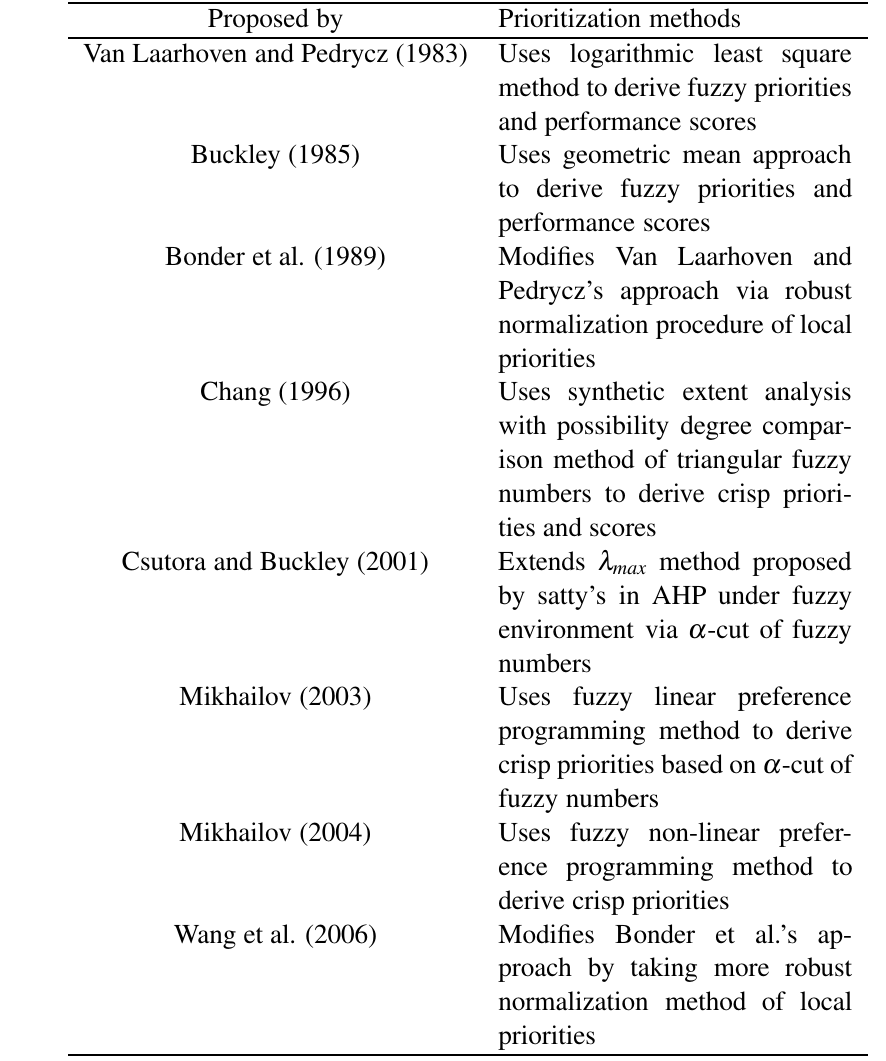
Table 1: The different approaches of deriving priorities from fuzzy pair-wise comparison